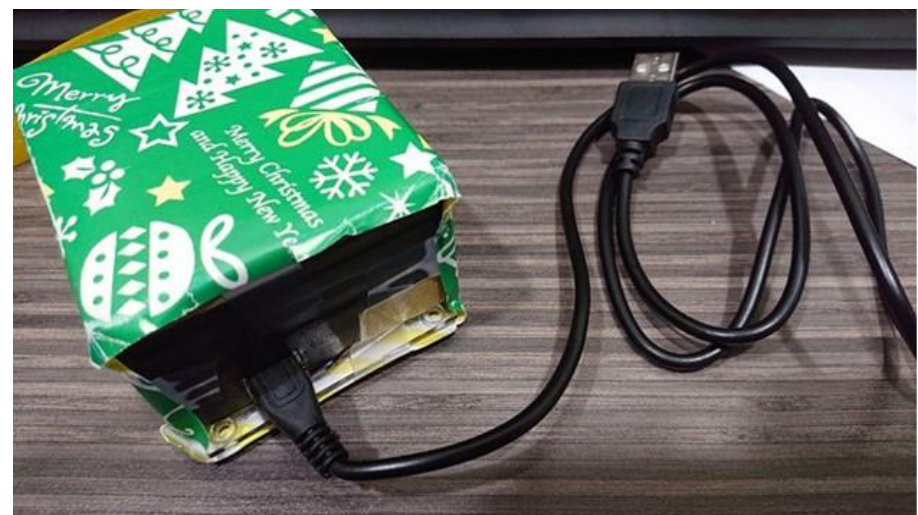
Figure 4. Case of CPGAFDWD.